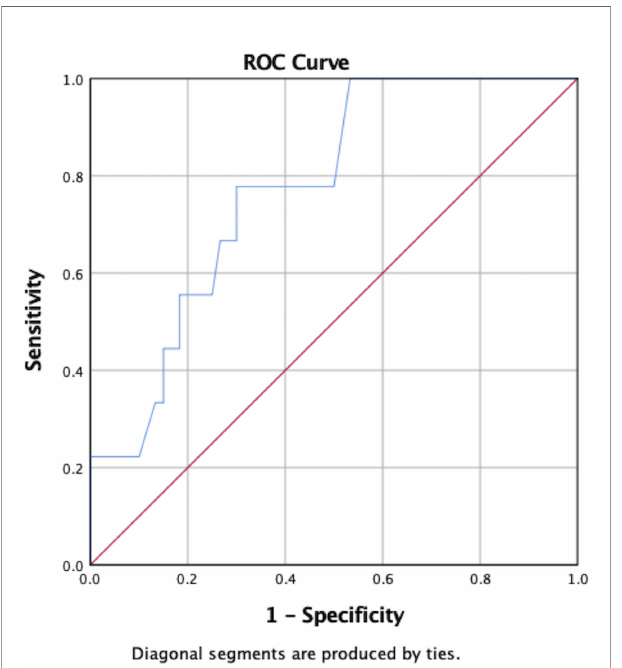
FIGURE 2 | ROC curve demonstrating change in IGF-1 from preoperative to 6- 12 week postoperative levels as a predictor of postoperative hormonal